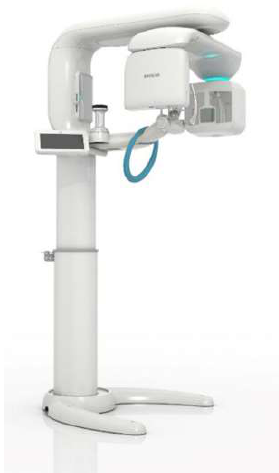
Figure 1. Rendering view of the RCT720.